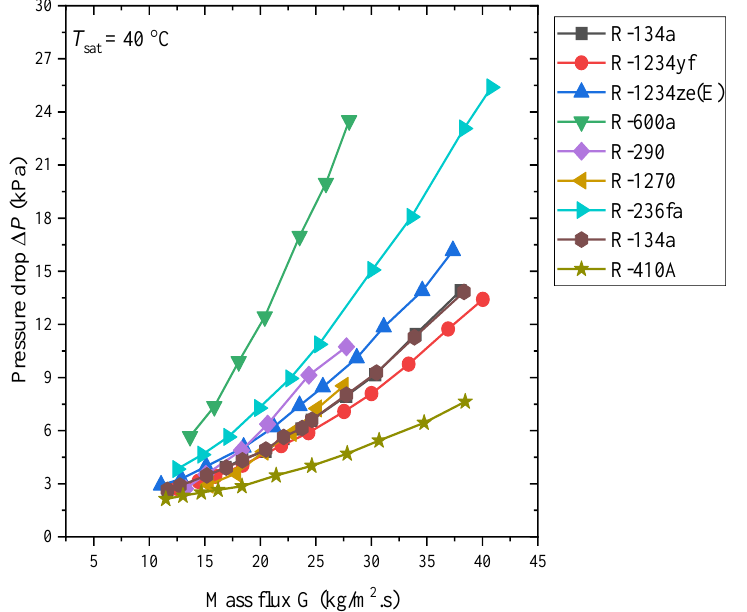
Figure 18. Condensation HTC of various refrigerants inside the plate heat exchanger. Rectangular, circular, and triangular upward solid connected lines present the Longo [75], Longo and Zilio [76] and Longo et al. [77] study respectively, triangular forward solid connected line presents the Longo [80] study, and the remaining symbols present the Longo [78] study.